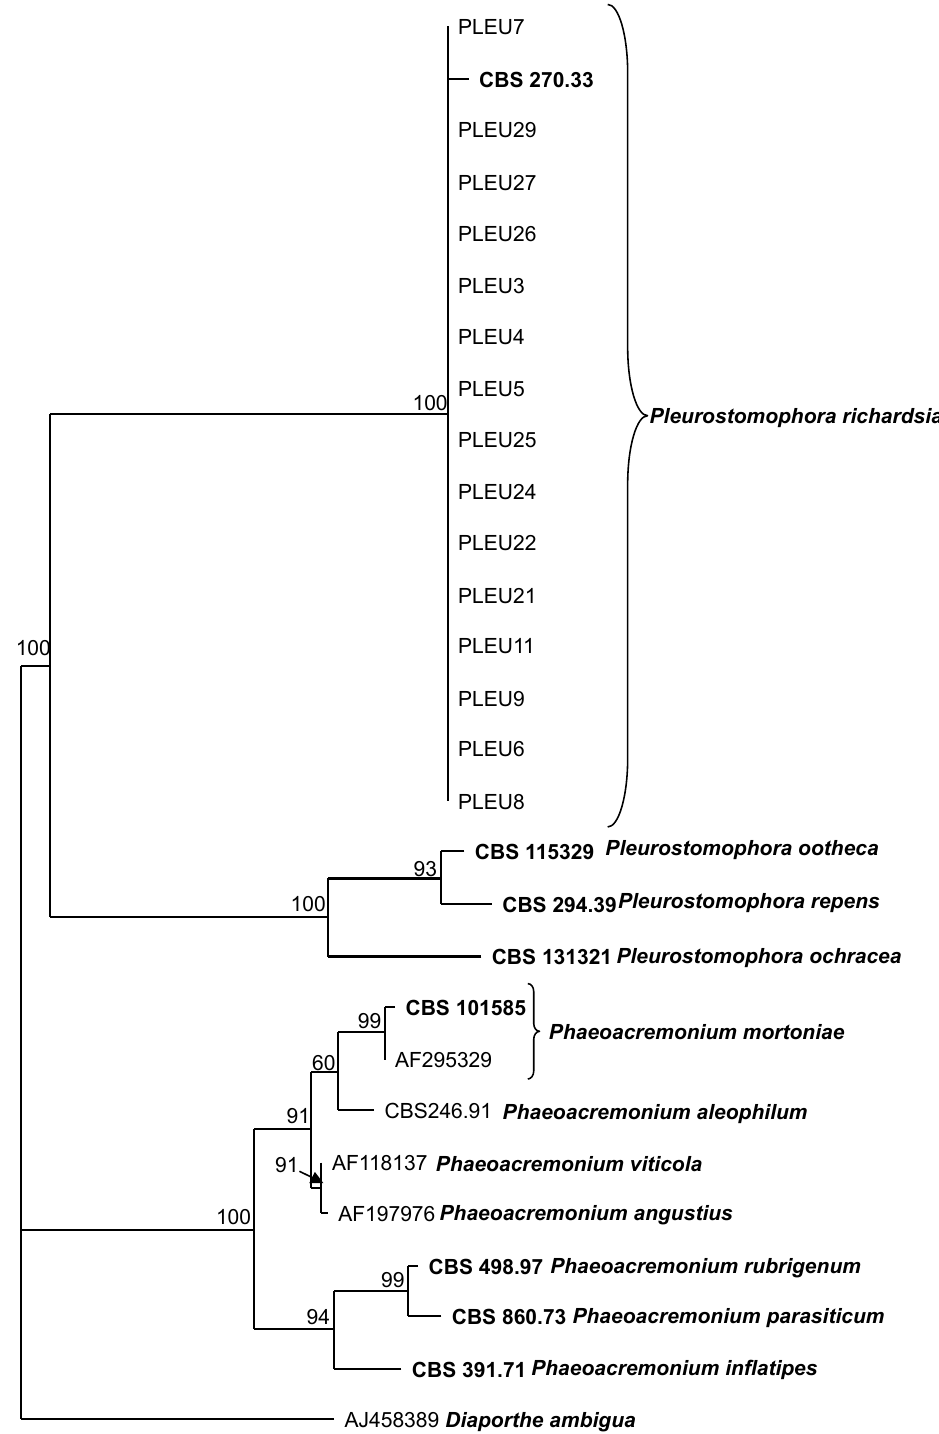
Figure 2. One of four most parsimonious trees obtained from heuristic searches of ITS sequence data. Bootstrap support values from 1000 replicates are shown at the nodes. The tree is rooted to Diaporthe ambigua